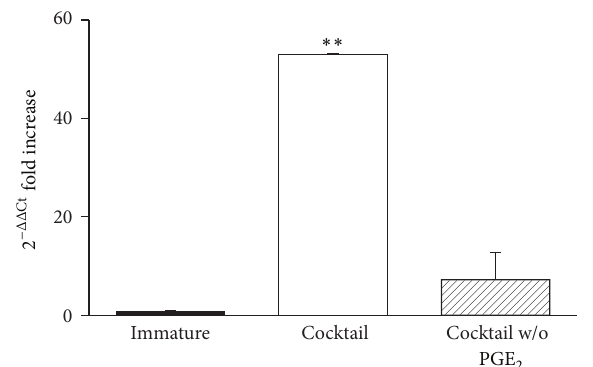
Figure 5: IDO1 expression is enhanced in Mo-DCs from AML patients matured with PGE 2 . Human CD14 + cells were isolated from PBMC of AML patients in complete remission by using magnetic beads. Immature Mo-DCs were obtained after a 5-day culture in presence of GM-CSF and IL-4. Mature Mo-DCs were obtained following 2 days of incubation with the cytokine cocktail made of IL-1 𝛽 , IL-6, and TNF- 𝛼 , with or without PGE 2 . Cells were lysed and RNA was extracted. mRNA expression of IDO1 (normalized to GAPDH) was evaluated by real-time RT-PCR. Universal human RNA was used as reference and taken as value of 1. Results are expressed as fold increase of gene expression over immature Mo- DCs (taken as referral condition). The results represent the mean of 3 independent experiments ± SEM. ∗∗ 𝑃 < 0.01 versus immature